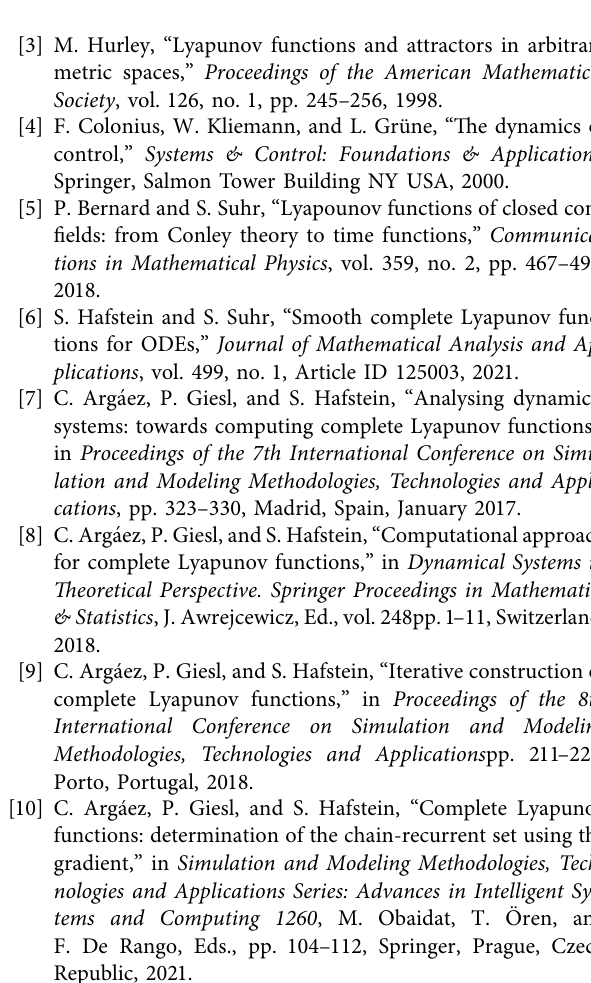
Figure 14: System (21). (a) The overestimation of the chain recurrent set 􏽥 X 0 � C refined estimate 􏽥 X 0 using the classification rule: two eigenvalues must be negative and one must be zero. (b) The results in the xy -plane, z �